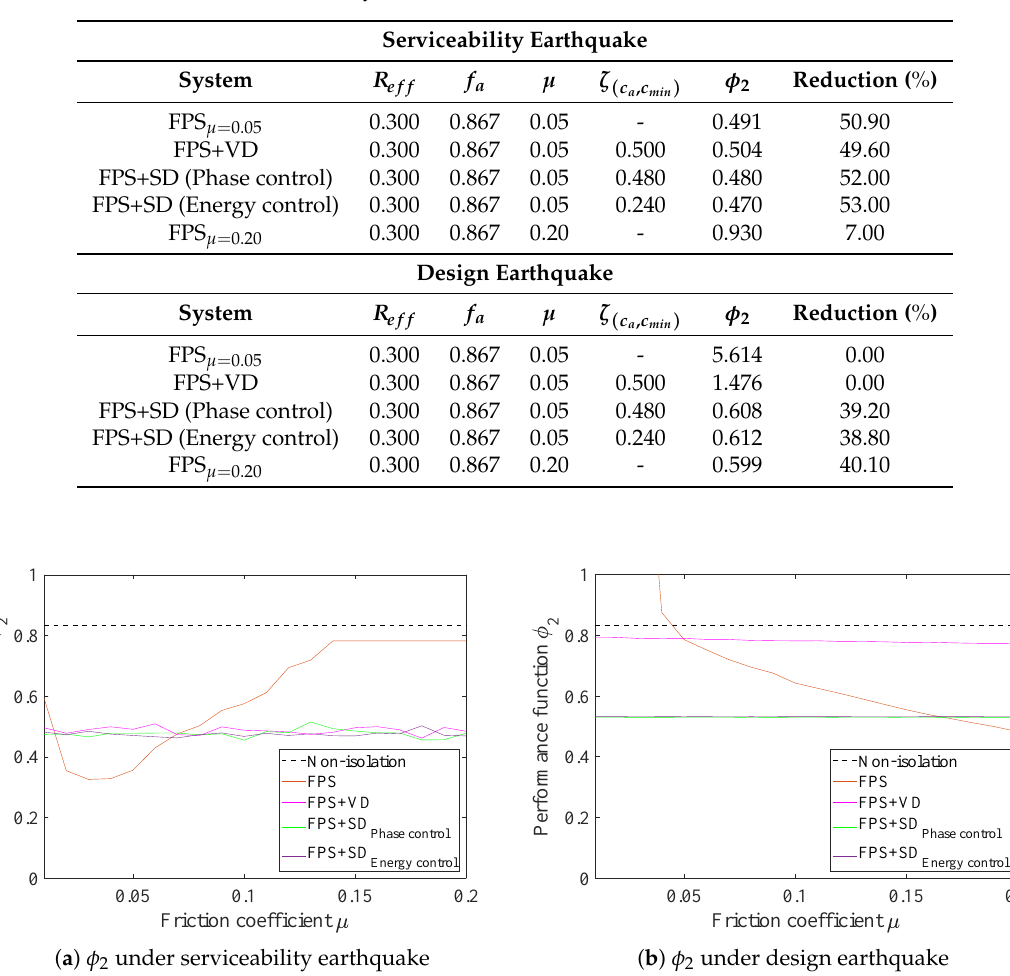
Figure 19. Performance function φ 2 and structure energy for a range of effective FPS